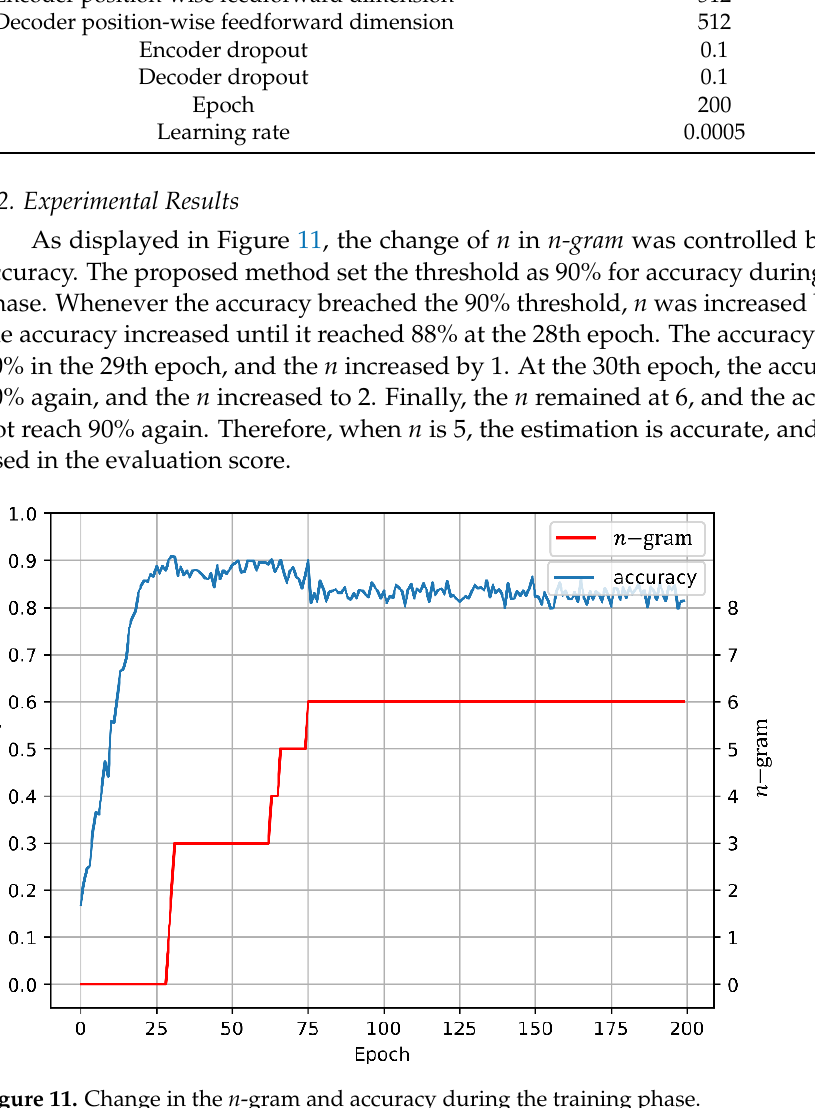
Figure 11. Change in the n- gram and accuracy during the training phase.